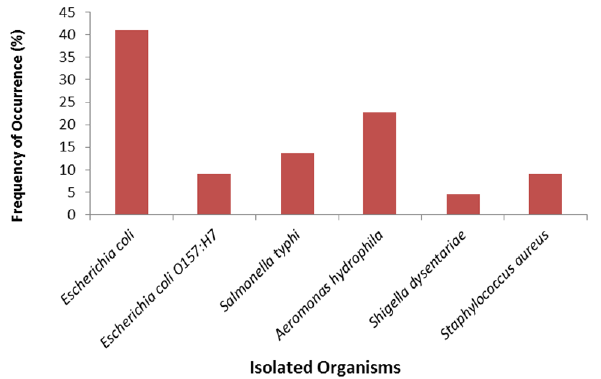
Fig. 1. Frequency of Occurrence of Isolated Organisms In Cow